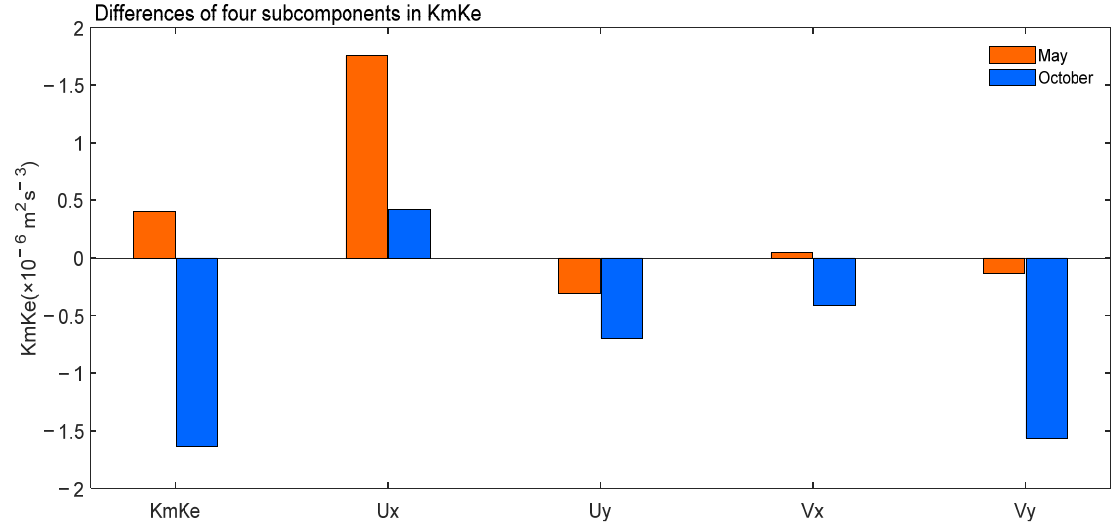
Figure 8. Differences of four regional mean subcomponents in the Kmke between P2 and P1 in May (red) and October (blue). The regional mean values were averaged over (5–20° N, 100–160° E).